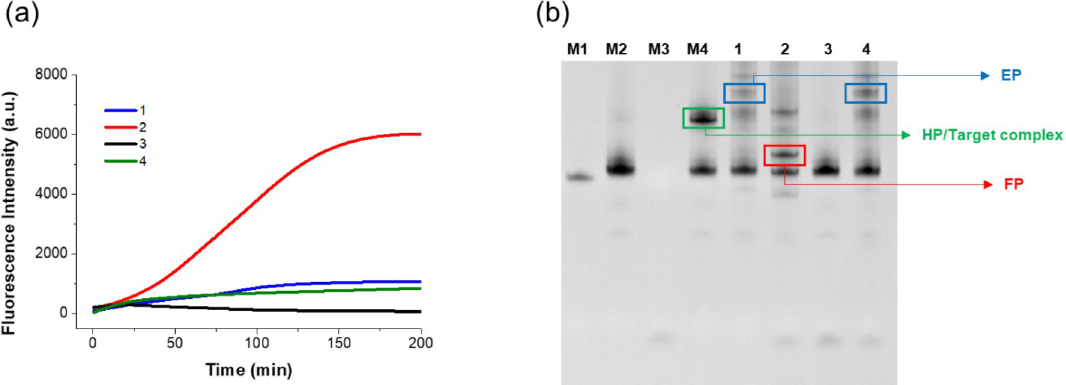
Figure 2. Feasibility of the PHAmp reaction. ( a ) Time-dependent fluorescence intensities produced from SYBR Green I staining during the PHAmp reaction (1: HP + Target DNA + Polymerase, 2: HP + Target DNA + Trigger + Polymerase, 3: HP + Trigger + Polymerase, and 4: Negative control HP + Target DNA + Trigger + Polymerase). The final concentrations of HP, trigger, polymerase, and target DNA are 50 nM, 1 μM, 0.125 U/μL, and 20 nM, respectively. ( b ) Polyacrylamide gel electrophoresis image of the PHAmp products (M1: Target DNA, M2: HP, M3: Trigger, M4: HP + Target DNA, 1: HP + Target DNA + Polymerase, 2: HP + Target DNA + Trigger + Polymerase, 3: HP + Trigger + Polymerase, and 4: Negative control HP + Target DNA + Trigger + Polymerase). In the PAGE analysis, the final concentrations of HP, trigger, polymerase, and target DNA are 500 nM, 1 μM, 0.125 U/μL, and 200 nM,